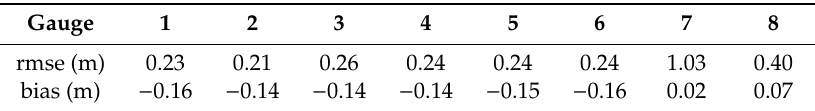
Table 2. Statistics correlating the free surface elevation time series predicted using XBeach and IH2VOF in case I.NO for gauges 1 to 8: bias and rmse.